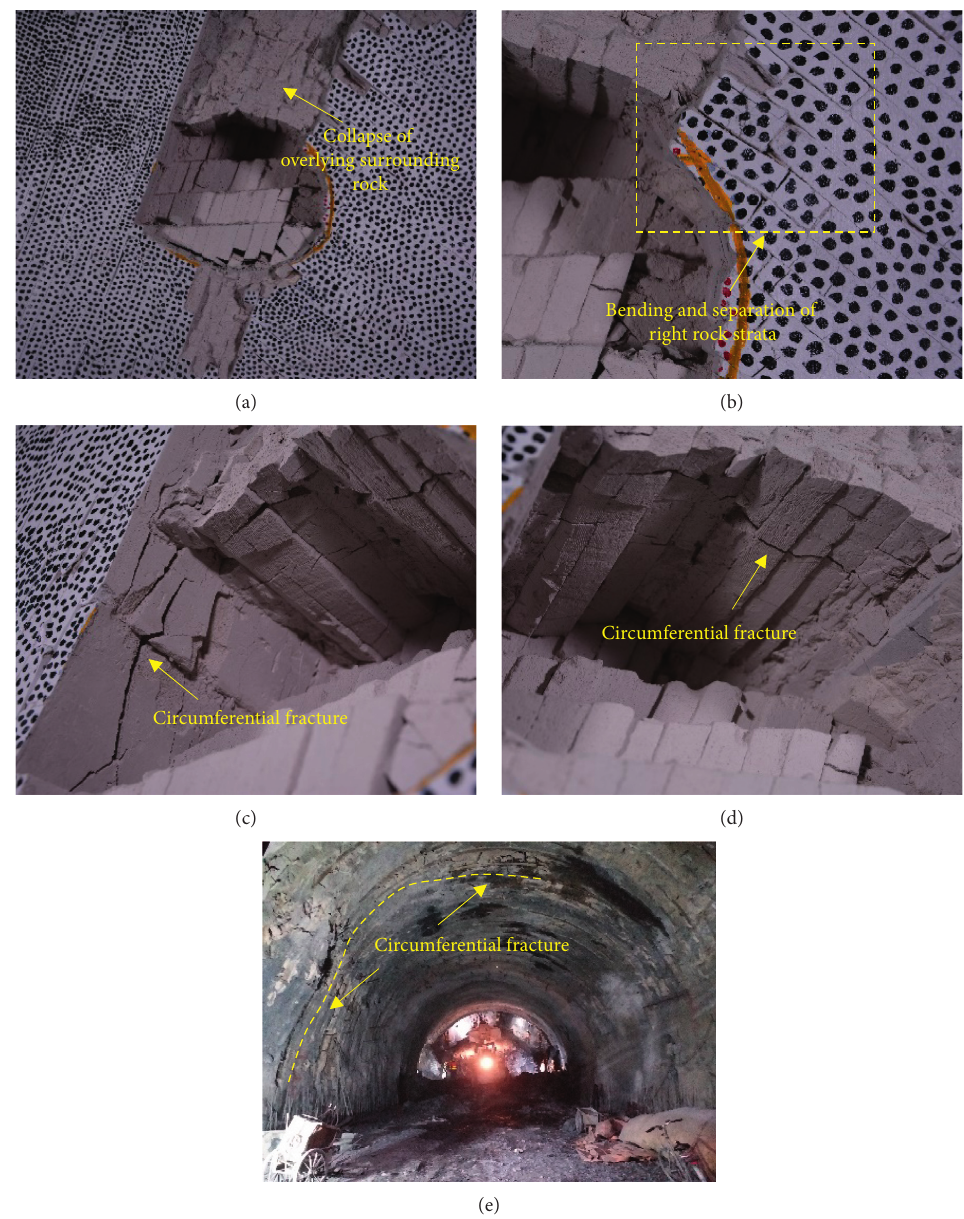
Figure 11: Excavation step E7 and deformations of surrounding